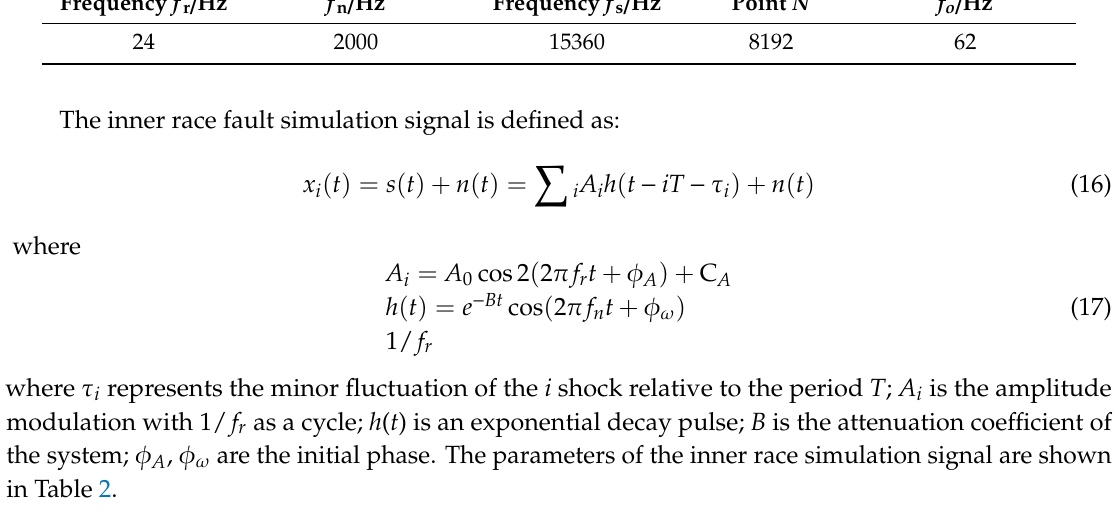
Table 2. The parameters of inner fault simulation signal.